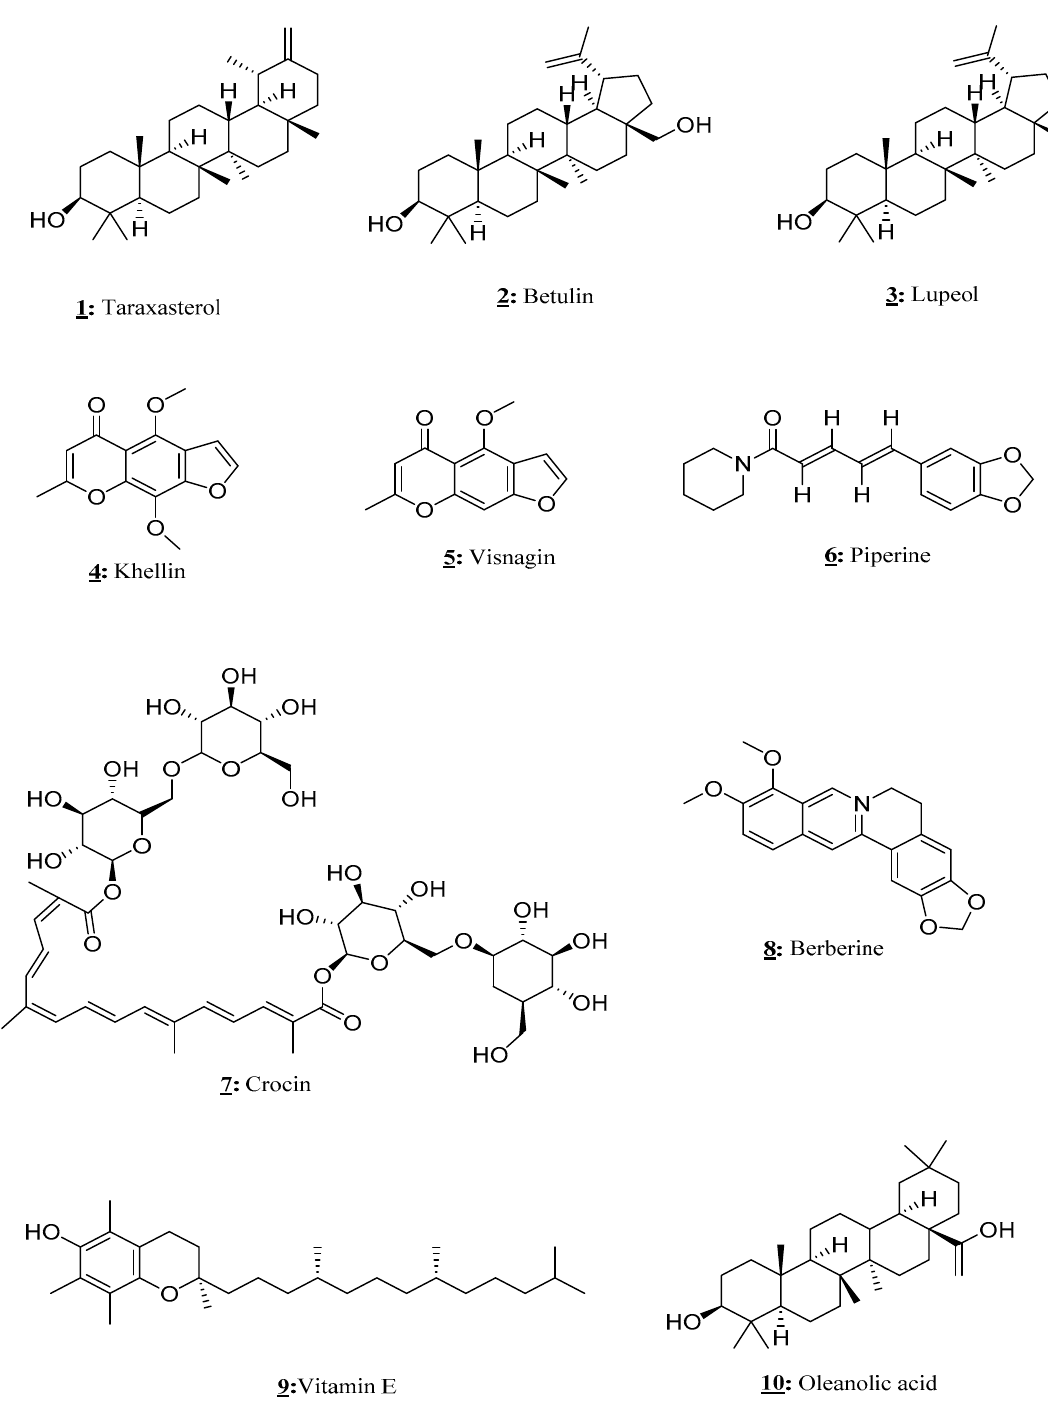
Figure 5. Chemical structures of other compounds with in vivo litholytic effects .